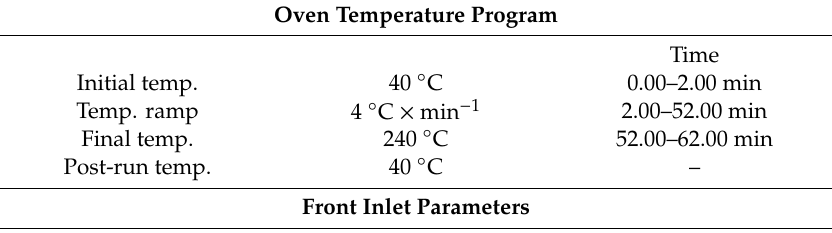
Table4. Gaschromatography–massspectrometryparametersforvolatileorganiccompoundsseparation and analysis. Oven Temperature Program Initial